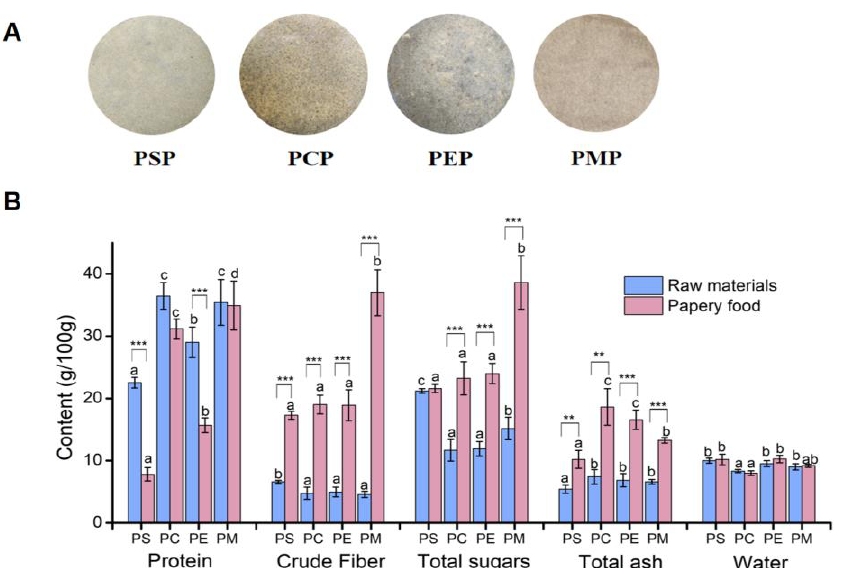
Figure 1. Nutritional composition of four raw materials and P. eryngii papery food. ( A ) Four P. eryngii papery foods prepared using the papermaking process. ( B ) The content of protein, crude fiber, total sugars, total ash, and water of raw materials and P. eryngii papery food. Each error bar indicates mean ± SD. The letters of each variable in each sample or raw material are compared. Bars sharing the same letters are not different at p = 0.05. Different letters indicate that the mean values of three replicates are significantly different between the treatments ( p < 0.05). The significant differences between the raw materials and papery food were indicated by *. ** refers to significant differences where p < 0.05; *** refers to significant differences where p < 0.01.